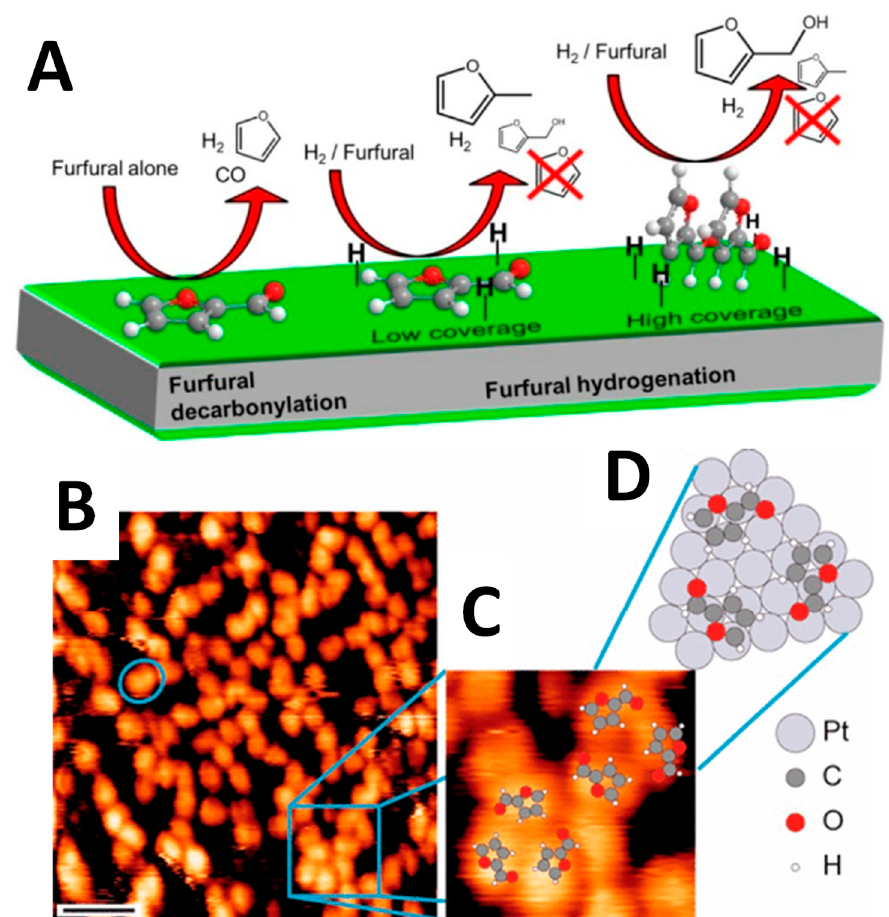
Figure 6. ( A ) Catalytic hydrogenation and hydrodeoxygenation of furfural over Pt(111); ( B ) STM image with a single furfural molecule indicated by the blue circle (T= 145 K,Vt= 1.28 V,It= 0.12 nA). Thescale bar (black line) is 2 nm. ( C ) Expanded area from panel B, indicated by the blue square, overlaid with an atomistic scale model with furfural in a planar geometry. ( D ) Model of proposed hydrogen-bonded network on the Pt(111). Adapted with permission from [172]. Copyright 2017 American Chemical Society.